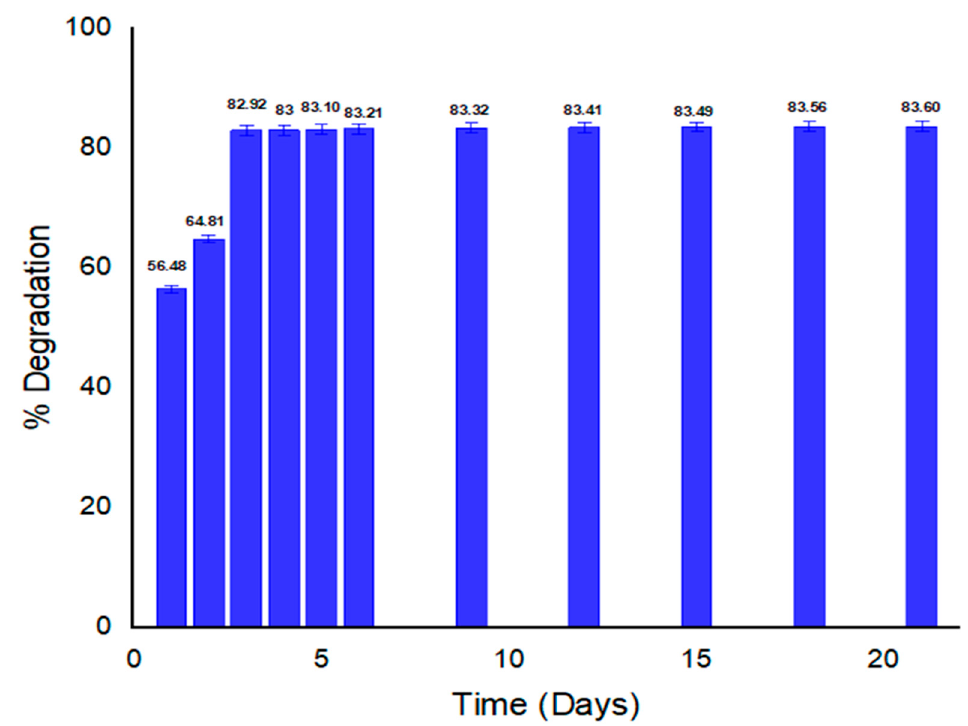
Figure 6. Effect of Incubation Time (Days) on Basic Orange 2 Dye % degradation.